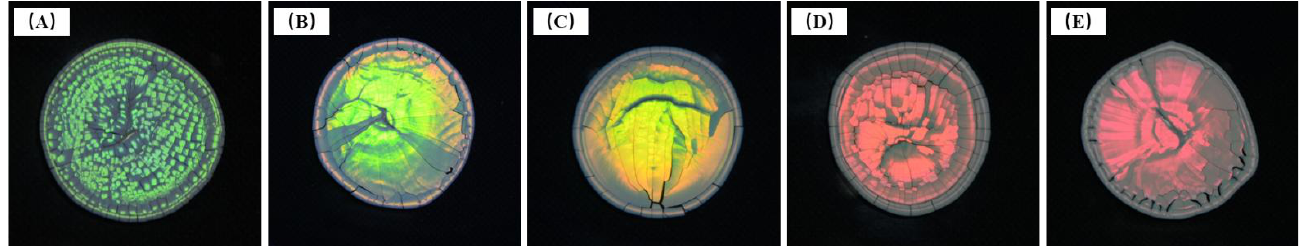
Figure 11. FE-SEM images of P(St-AA) colloidal microspheres synthesized with different reaction